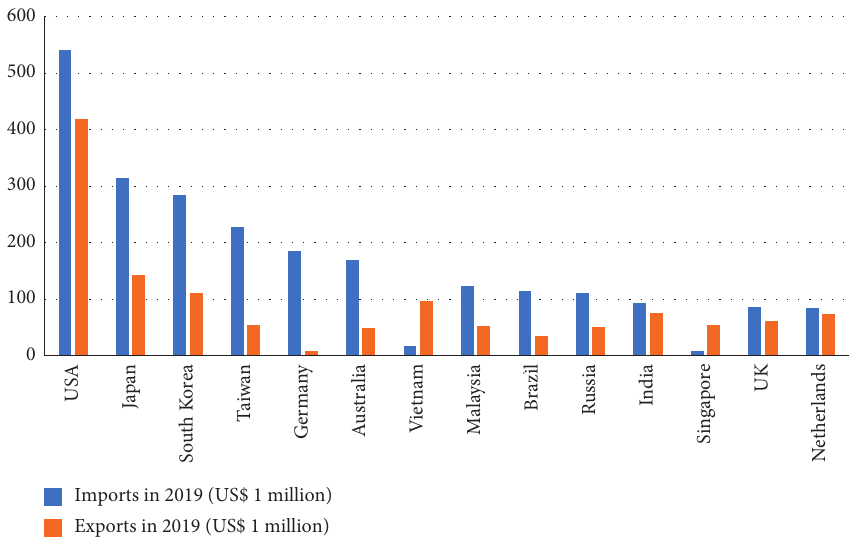
Figure 2: China’s top 10 trade partners in 2019. Source: General Administration of Customs of